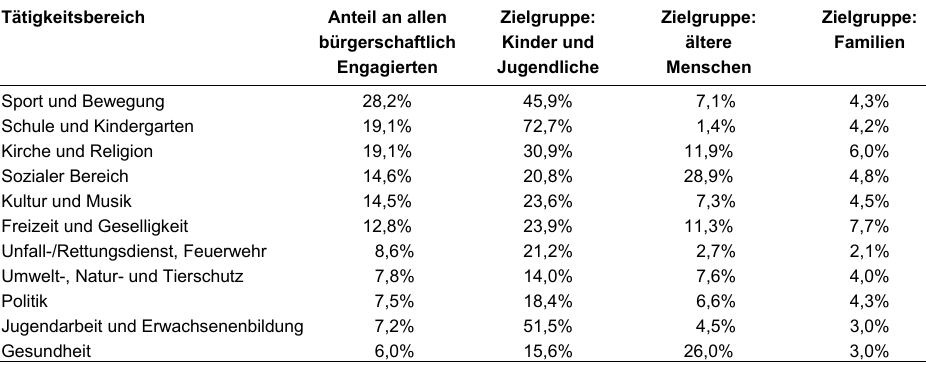
Tabelle 1: Bürgerschaftliches Engagement nach Tätigkeitsfeldern und Zielgruppenorientierung